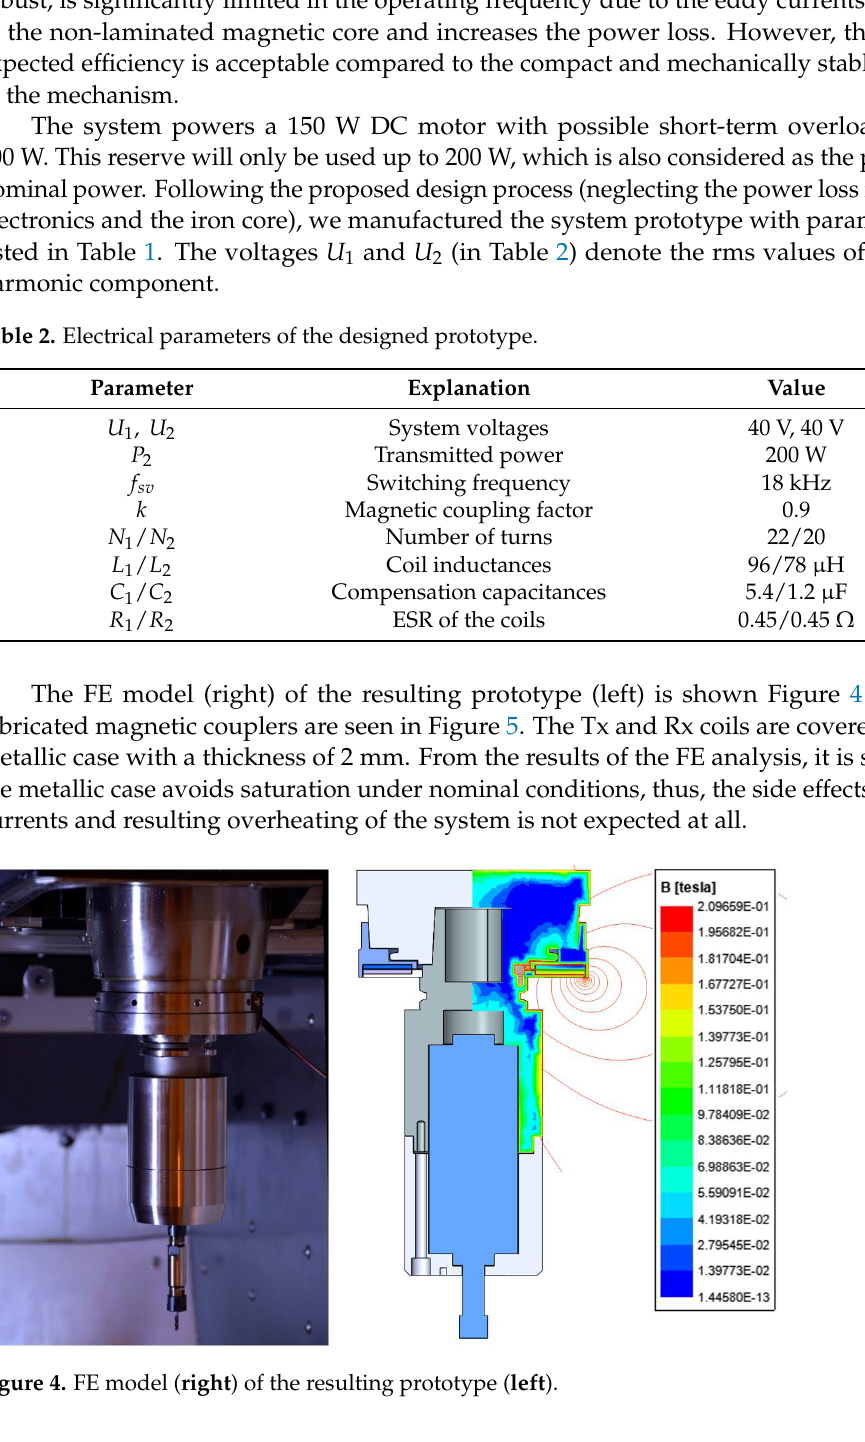
Figure 5. Magnetic couplers located at the top of the machining spindle clamping head. 4. Design of the WPT System for the Specific Application Prototype The simplified block diagram of the experimental set up is shown in Figure 6 . The measurement was performed without a secondary rectifier; thus, we were able to directly determine the efficiency of the WPT and evaluate the effect of the massive iron core. Due to the losses generated inside the core, the quality factors of TX and RX are low, therefore, the transmitter is powered by a regulated source including a sine-wave filter to reduce THDi as much as possible. The low-inductive load is connected to the receiver. The system efficiency is measured with the precision power meter Yokogawa PX8000 considering the AC-side powers P 1 and P 2 , indicated in Figure 2.